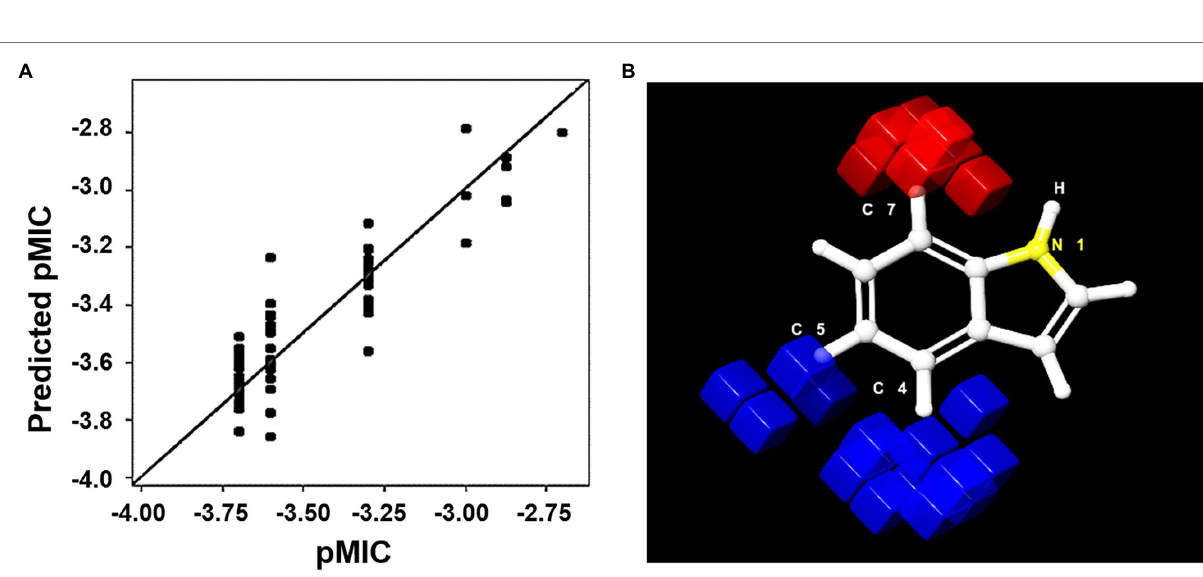
FIGURE 6 | Gene expression profiles in the presence of indoles. * p < 0.05 vs. non-treated controls. The rrsG gene was used as a housekeeping